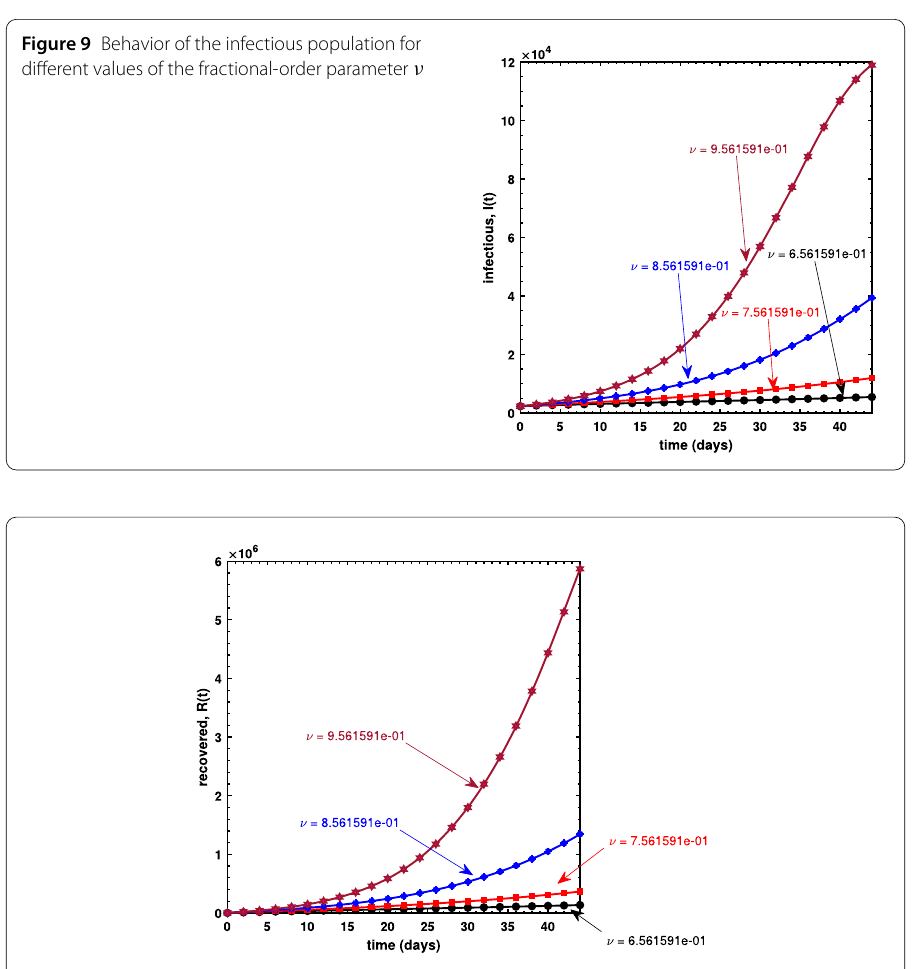
Figure 10 Behavior of the recovered population for different values of the fractional-order parameter ν